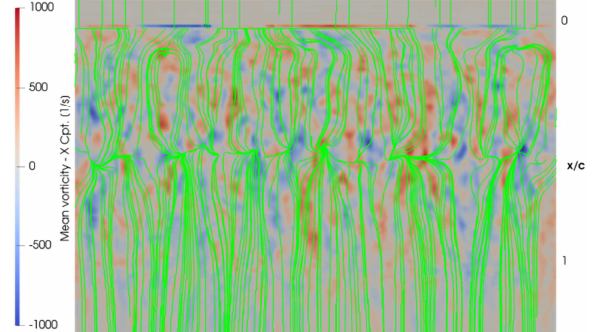
Fig. 7 . Plane y w /c = 0.01 m . Mean spanwise vorticity contours and surface vector lines of mean